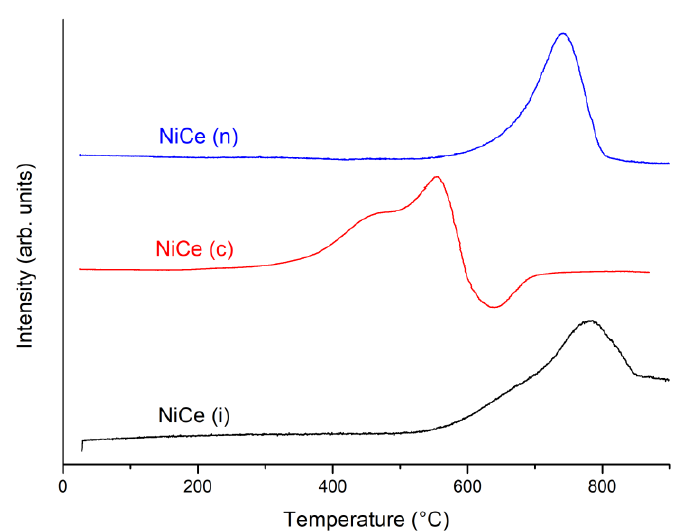
Figure 8. Carbon Mapping and EDX spectra of spent catalysts: ( a ) used NiCe (i); ( b ) used NiCe (c); ( c ) used NiCe (n).